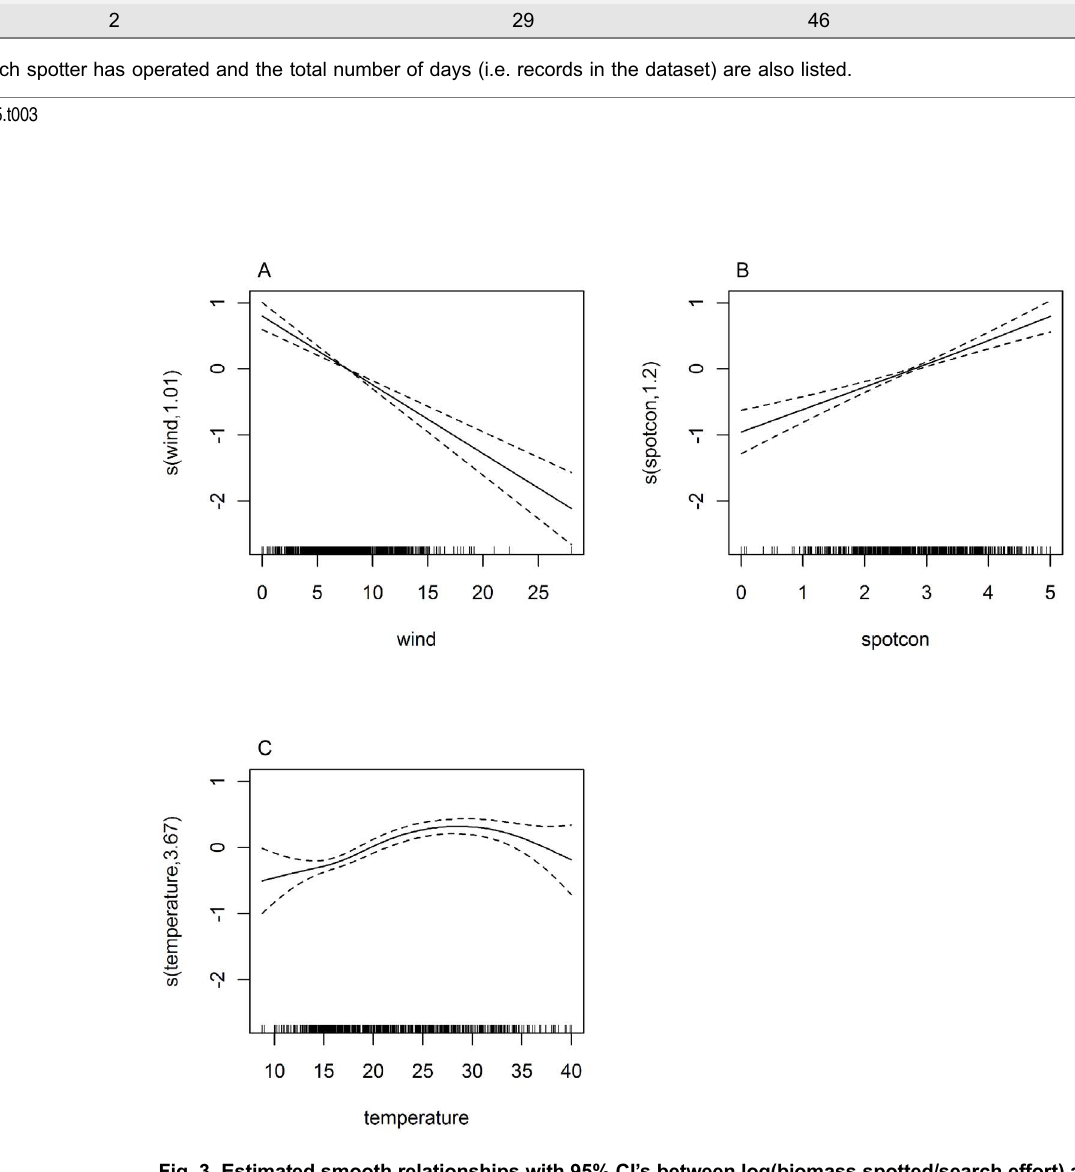
The number of seasons each spotter has operated and the total number of days (i.e. records in the dataset) are also listed.